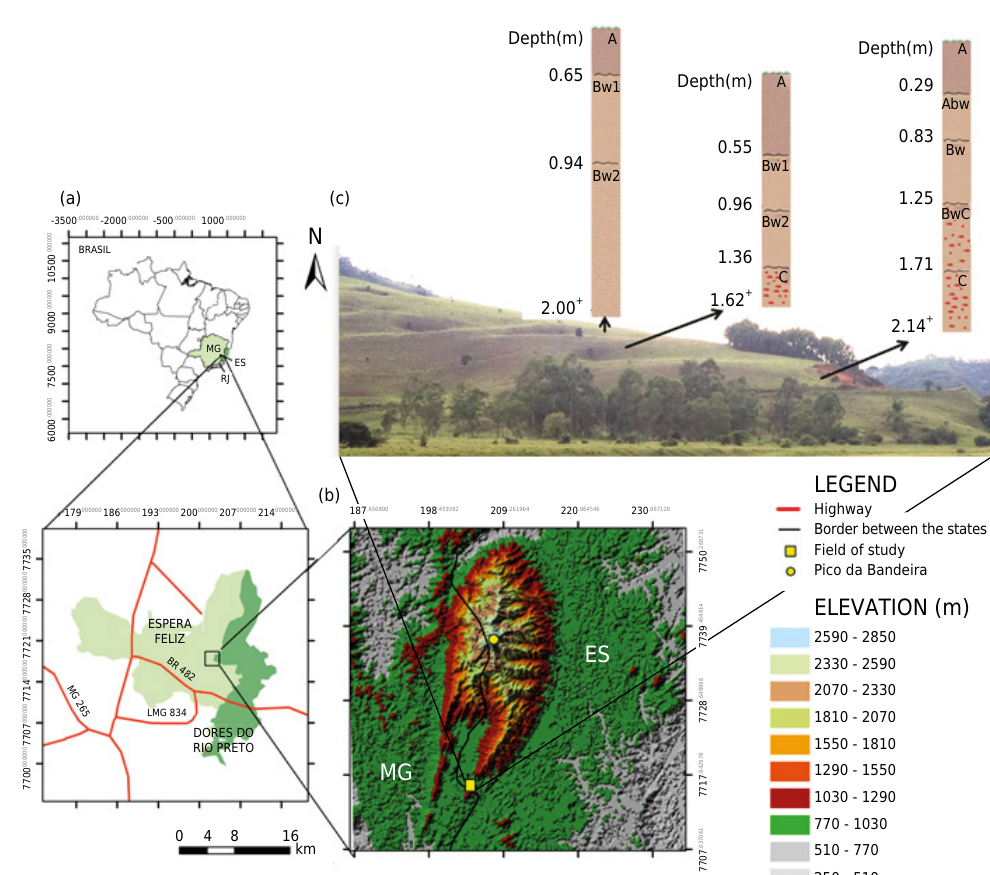
Figure 1. Location and access maps of the study area. (a) Main access routes to the towns of Espera Feliz, MG and Dores do Rio Preto, ES. (b) Location of the slope to the south of the Pico da Bandeira on an Aster image. (c) Slope image that shows the regions where the soil sampling pits were dug and describes the horizons and depths of profiles L1, L2, and